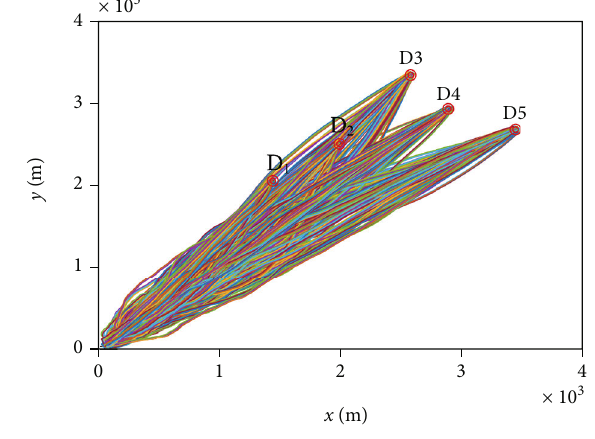
Figure 6: Cluster motion